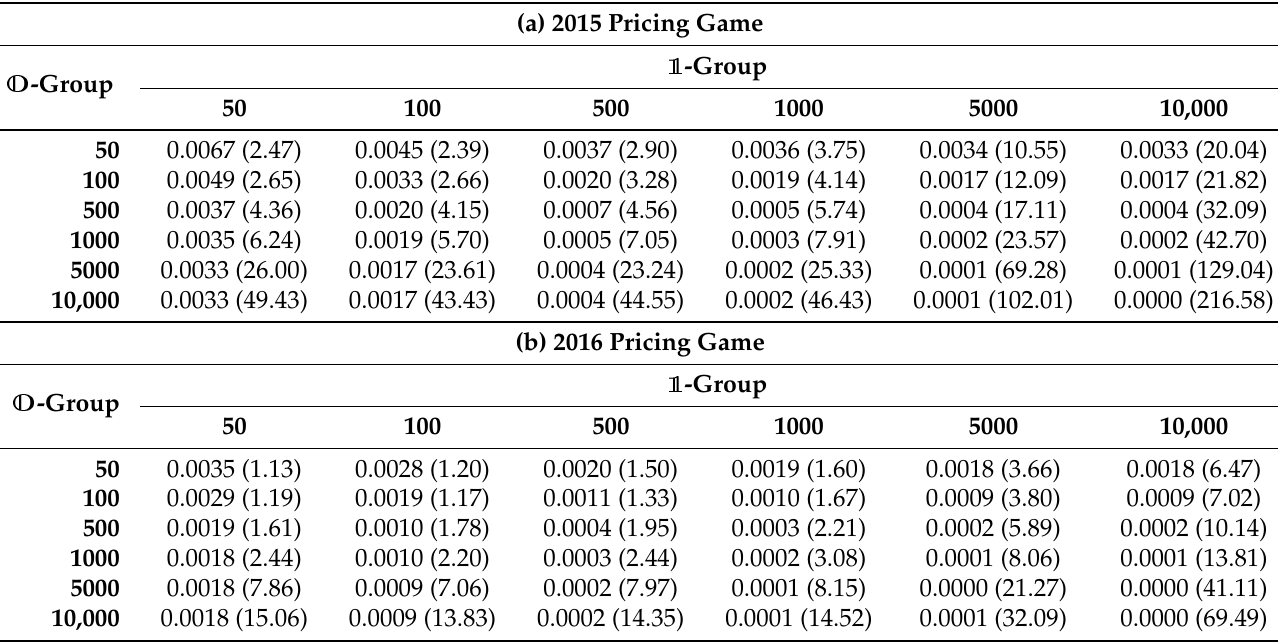
Table A1. Bias and run time (s), the latter between brackets, for the extended marginal approximation of C ≈ 2015 and 2016 pricing game dataset. This is given for the fine grid version and for several different numbers of boundary values for the O - and 1